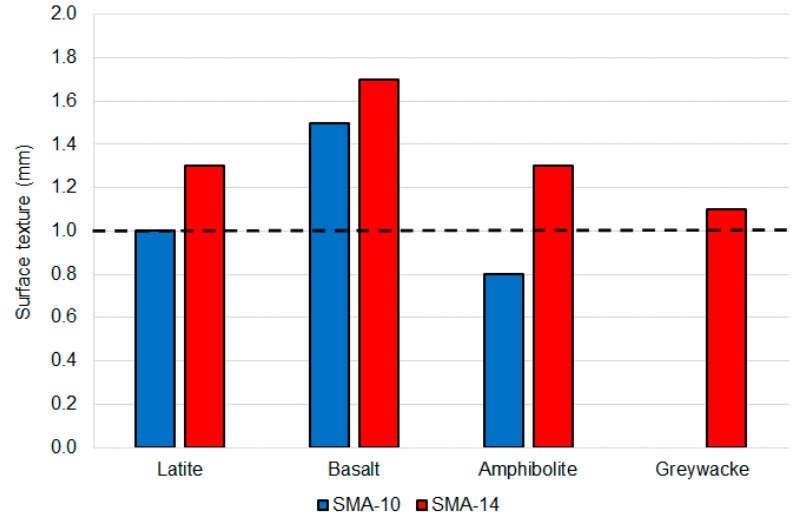
Figure 11. Average SMA surface texture summary.